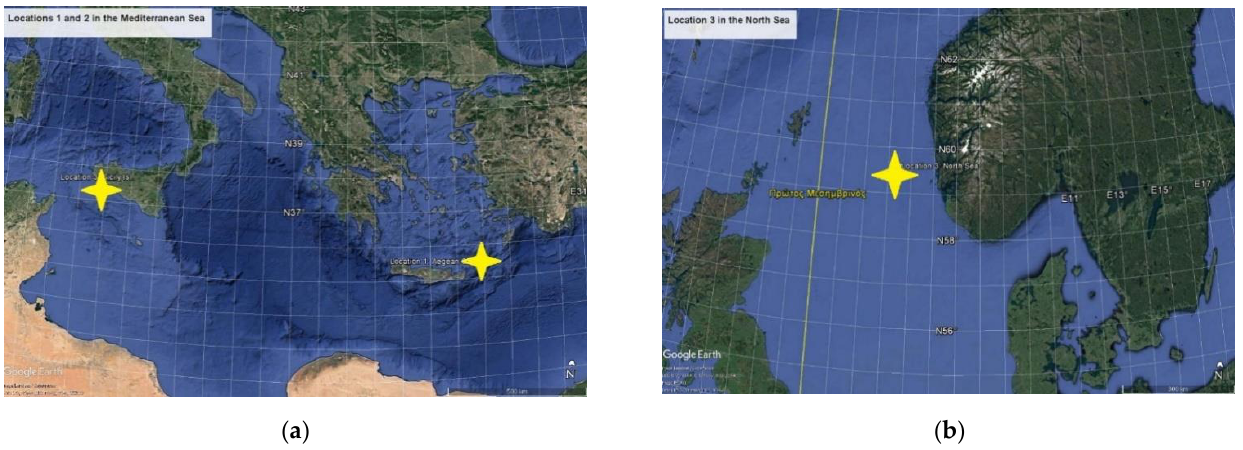
Figure 3. Examined installation locations (yellow stars) for the REFOS platform: ( a ) two locations L1, L2 in the Mediterranean Sea; ( b ) one location L3 in the North Sea (from Google Earth).